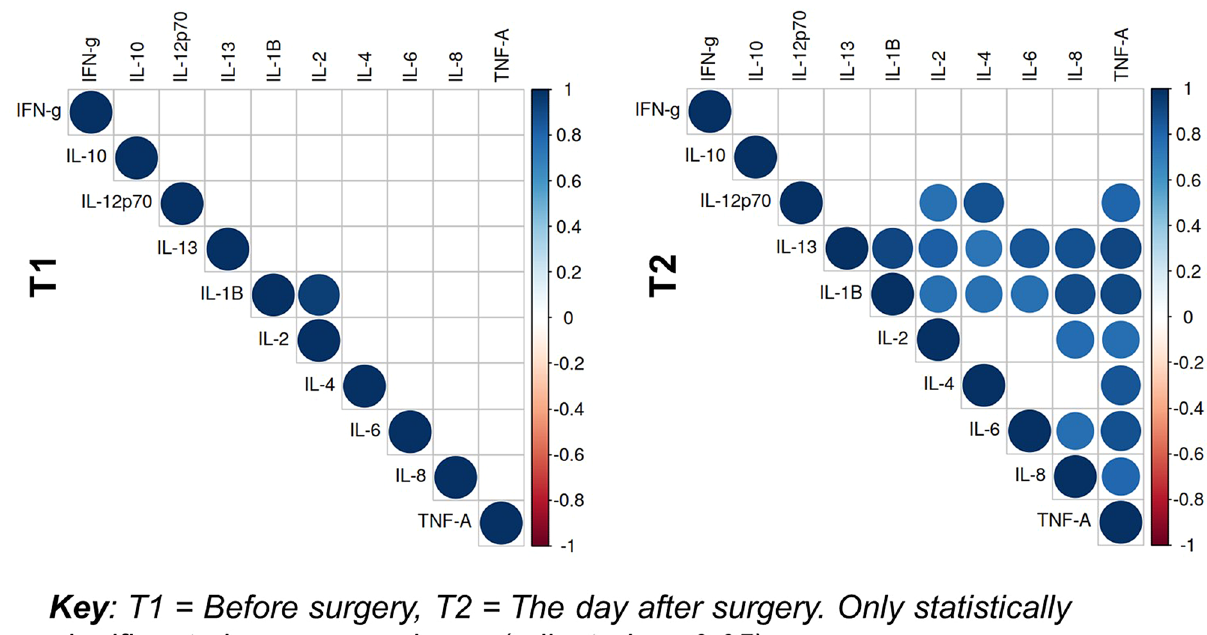
Figure 2. Correlation plots between CSF cytokines before and after surgery. Correlation plots between cytokines for cerebrospinal fluid (CSF) before surgery (T1) and the day after surgery